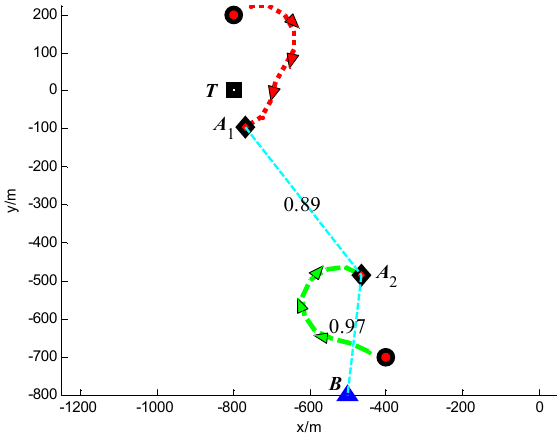
Figure 18. Trajectories of UAVs at t = 10 s (Group A in Scenario 2).